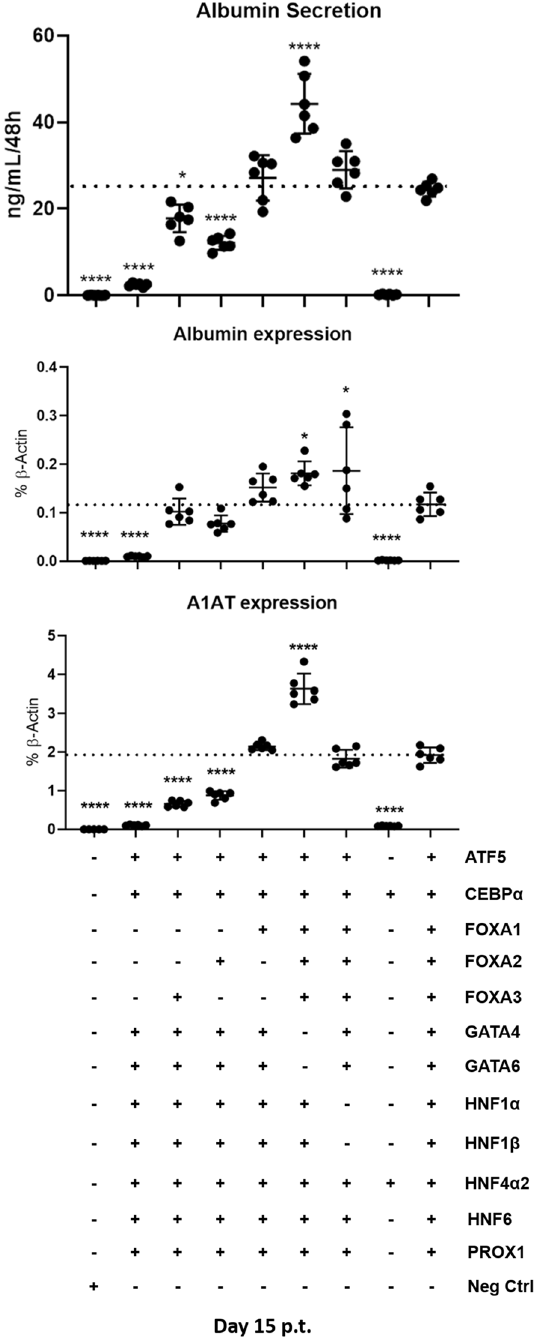
Figure 3. Second step of transcription factor screening in PKFs. Albumin secretion (upper panel), ALBUMIN and A1AT gene expression levels (medium and lower panel, respectively) in PKFs transduced with 12 TFs minus families of factors such as the FOXAs , GATAs and HNF1α ; HNF1β . All data were analyzed using one- way ANOVA, with Tukey’s post-test. Significance from n = 6 independent values is displayed as *p < 0.05; ****p ≤